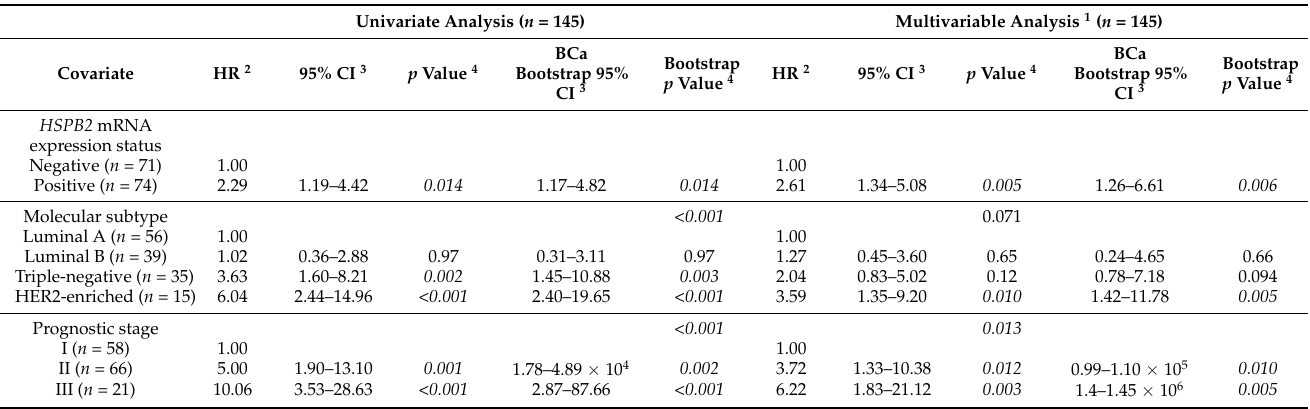
Table 3. HSPB2 mRNA expression status and disease-free survival (DFS) of BrCa patients. Univariate Analysis ( n =